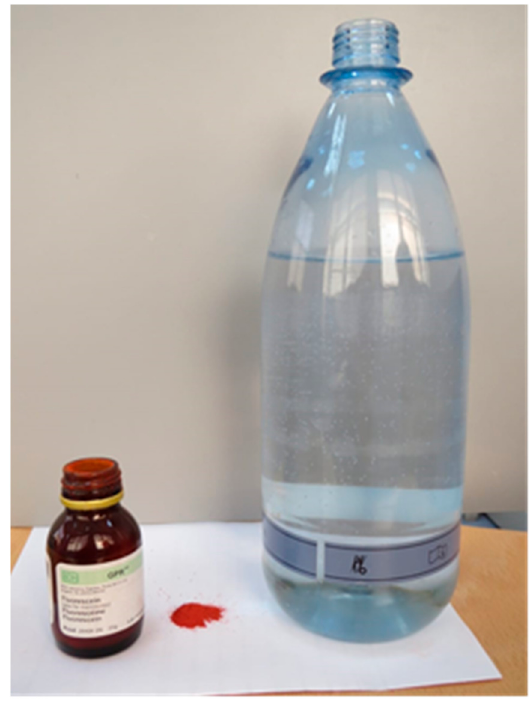
Int. J. Environ. Res. Public Health 2021 , 18 , x Figure 3. Dispersion of the ultra-filtrate containing the fluorescent dye. Figure 3. Dispersion of the ultra-filtrate containing the fluorescent dye.